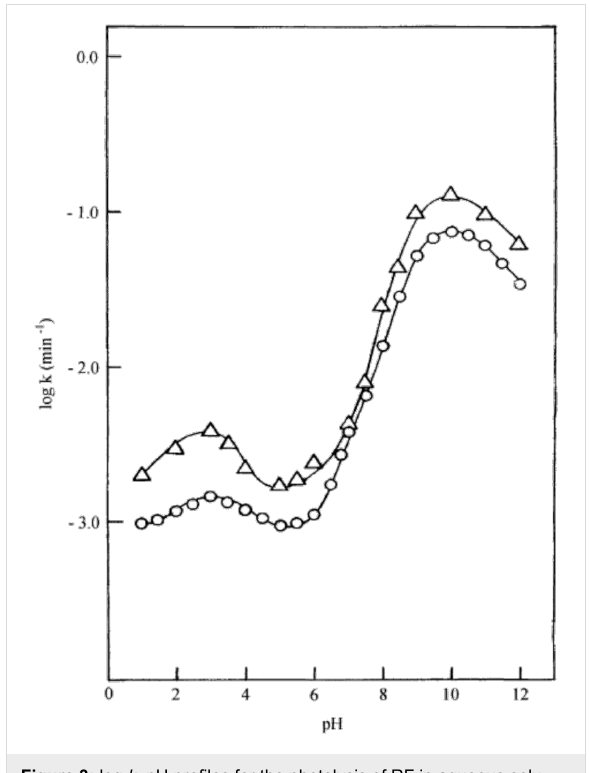
Figure 3: log k –pH profiles for the photolysis of RF in aqueous solu- tion using UV light ( ∆ ) and visible light ( ○ ). UV lamp emission at 313 and 366 nm (125 W medium pressure mercury vapor lamp, 2.19 ± 0.12 × 10 18 quanta s − 1 ), Visible lamp emission at 405 and 435 nm (Philips HPL N 125 W high pressure mercury vapor fluorescent lamp, 1.14 ± 0.10 × 10 17 quanta s − 1 ). Reproduced with permission from [24]. Copyright 2004